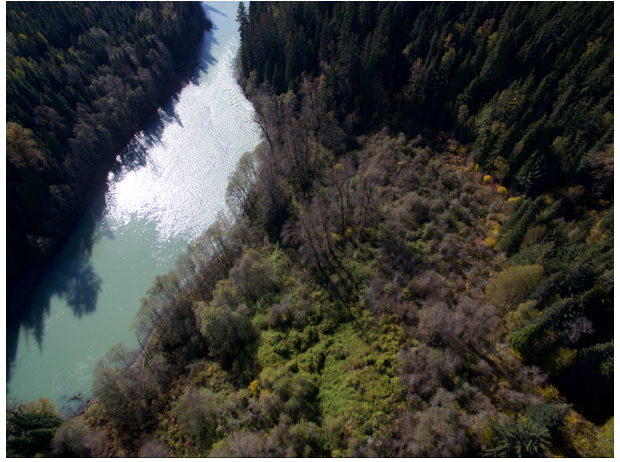
Fig. 1 . The Village complex of Dałk Gyilakyaw consists of three discrete villages and is the ancestral home of Gitsm’geelm (Ts’msyen) people. Note the dramatic vegetation change between the forest garden and encroaching conifers (“periphery forests”). Photograph: S. Carroll.